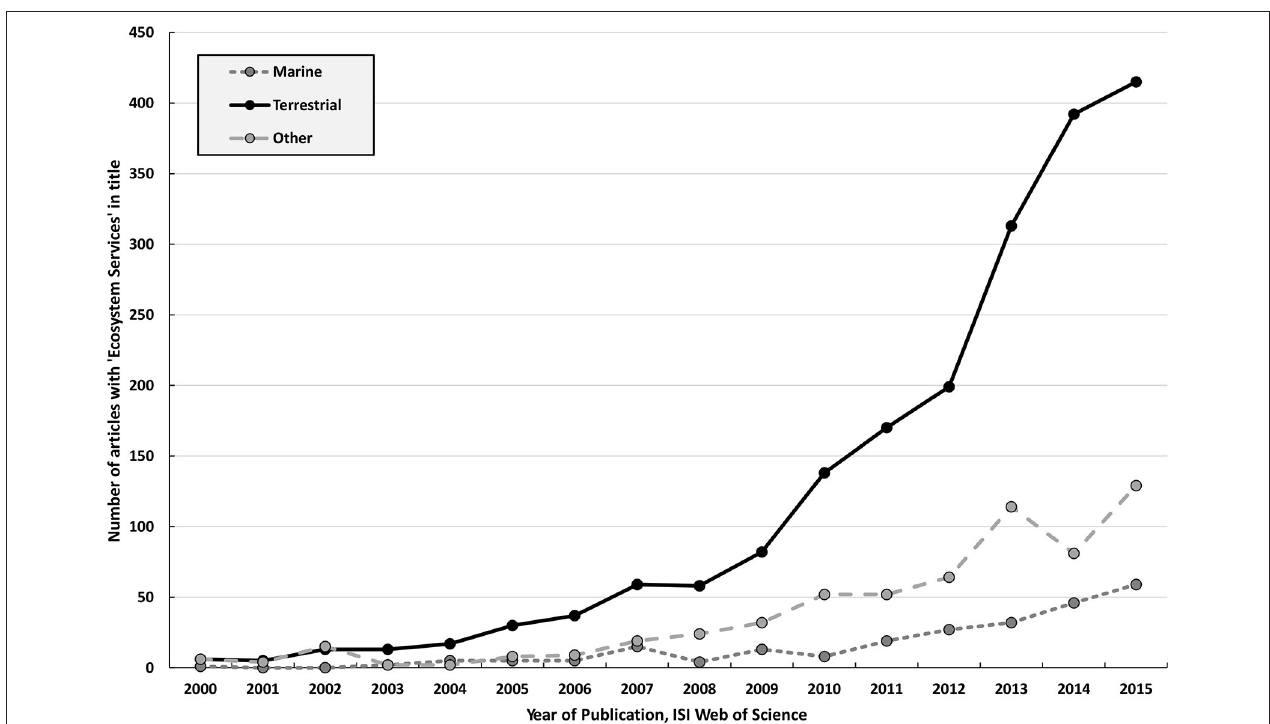
FIGURE 1 | The occurrence of “ecosystem service” in publications titles, broken down by subject area, listed in ISI Web of Science from 2000 to 2015. “Ecosystem Service” was entered as a title search word, with year published used to demarcate time intervals. All papers abstracts were reviewed and assigned to one of three groups (“marine,” “terrestrial.” or “other”) and enumerated. Anomalies were removed including e.g., IT “digital service ecosystems,” articles retracted after publication and duplicated entries. “Marine” articles had a clear reference to, and a major focus on, only marine habitats (estuarine to deep-ocean). In keeping with ( Costanza et al., 1997, 2014) Wetlands were classified as terrestrial studies but mangroves were classified as marine if they specifically related to fisheries. “Terrestrial” articles had a predominant focus on the earth’s continents including forests, agroforestry, agriculture and grasslands, urban environments, lakes and rivers or a single or limited group of services predominating from terrestrial systems. “Other” articles referred to those that could not be classified as either marine or terrestrial. Some articles focused on specific services that referenced both marine and terrestrial systems i.e., climate focused. Other articles focused on the organization, valuation of or payment for, classification, frame-working, management or governance of ecosystem services without specifically relating to either marine or terrestrial